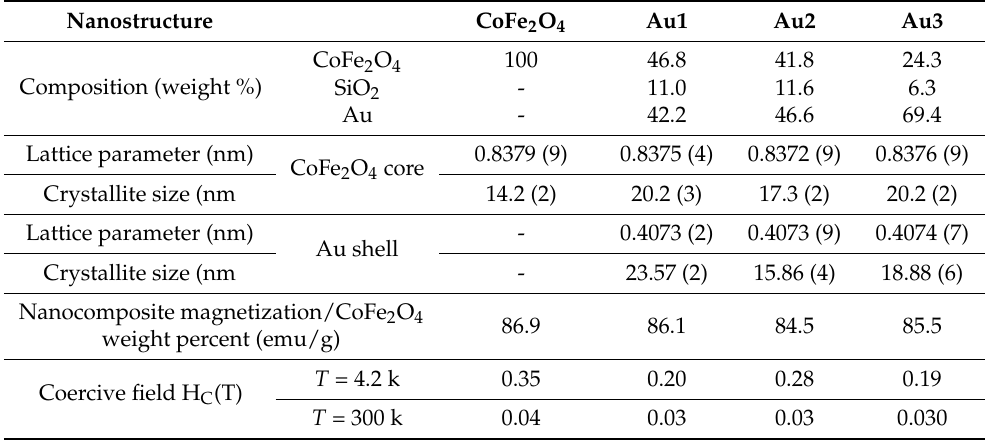
Figure 1. XRD patterns of CoFe 2 O 4 and CoFe 2 O 4 @SiO 2 @Au nanocomposites and the results of Rietveld refinements. Table 1. Compositions, lattice parameters, crystallites sizes, magnetizations and coercive fields.